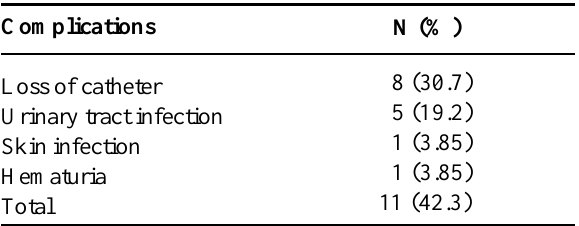
Table 4 – Postoperative complications related to the pro- cedure.